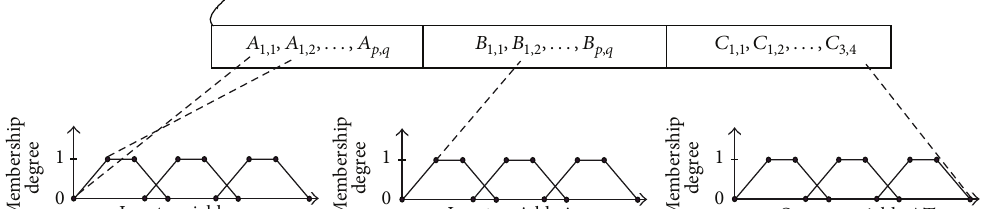
and 𝐴 1,2 is the second parameter. Following this, all parameters are coded on a YCC and 𝐶 represents the output YCC